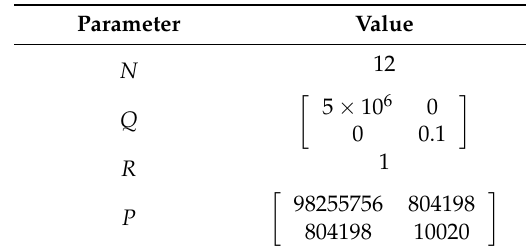
Table 3. OF-MPC design